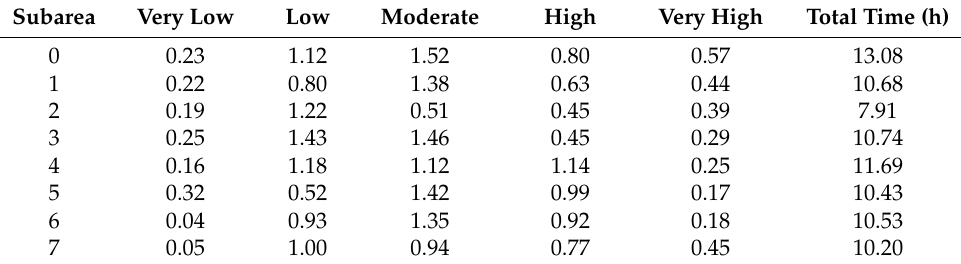
Table 7. Total cruise time for each category when using multiple UAVs.